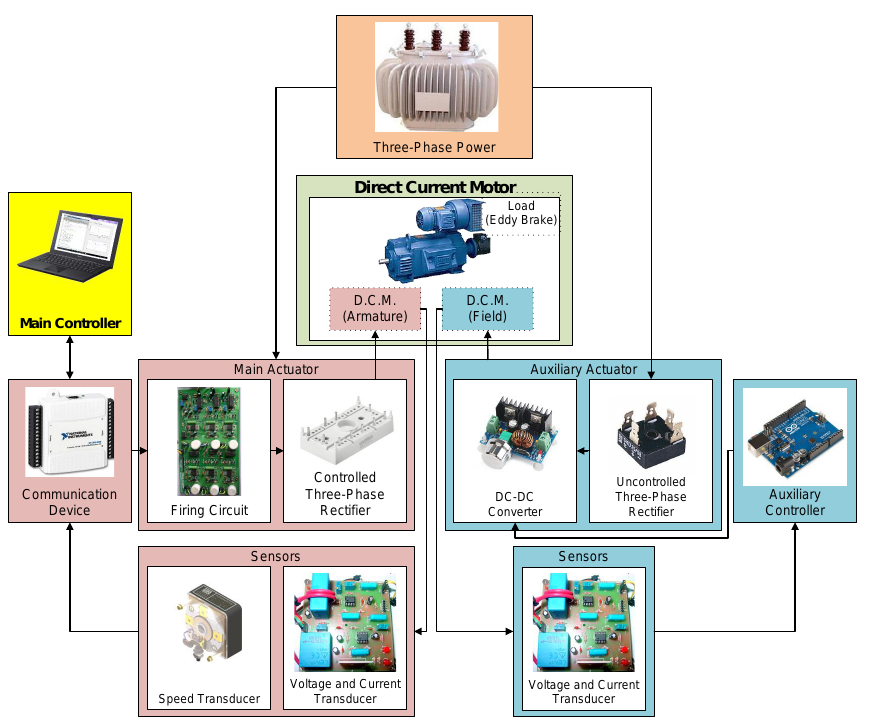
Figure 6. Block diagram of the implemented